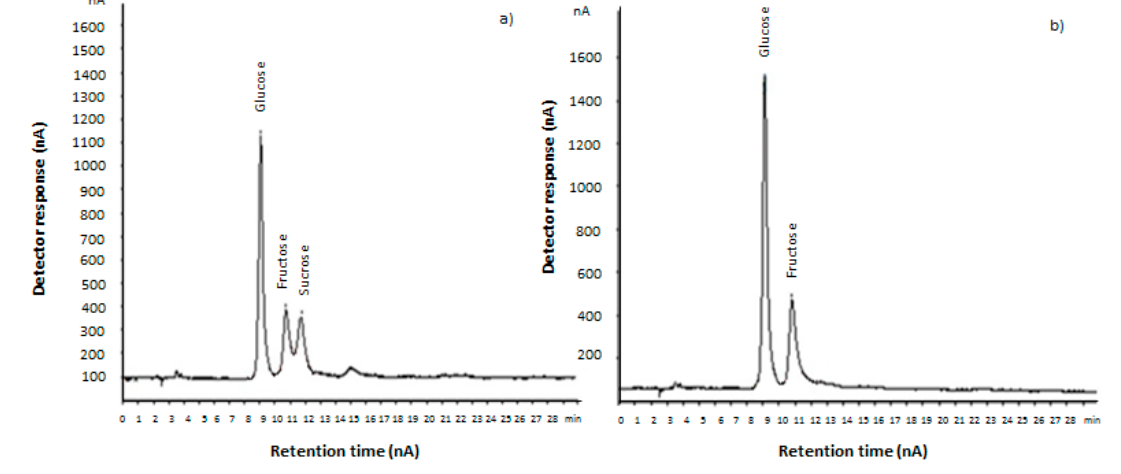
Figure 2. HPAEC-PAD chromatograms (dilution 1:2000 v/v) for ( a ) pineapple waste before saccharification (0 h); and ( b ) saccharified pineapple waste (24 h).